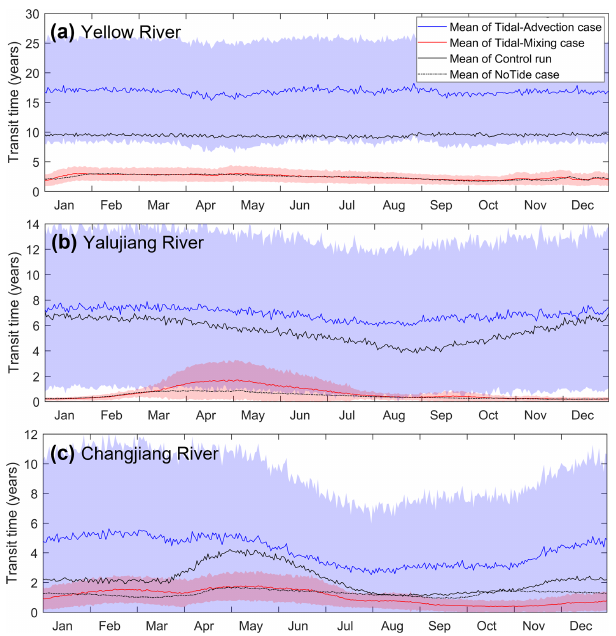
Figure 9. The daily mean water transit time over the shelf of the three rivers for the tidal–advection case (blue) and tidal–mixing case (red), along with the control run (black) and no-tide case (dotted black).